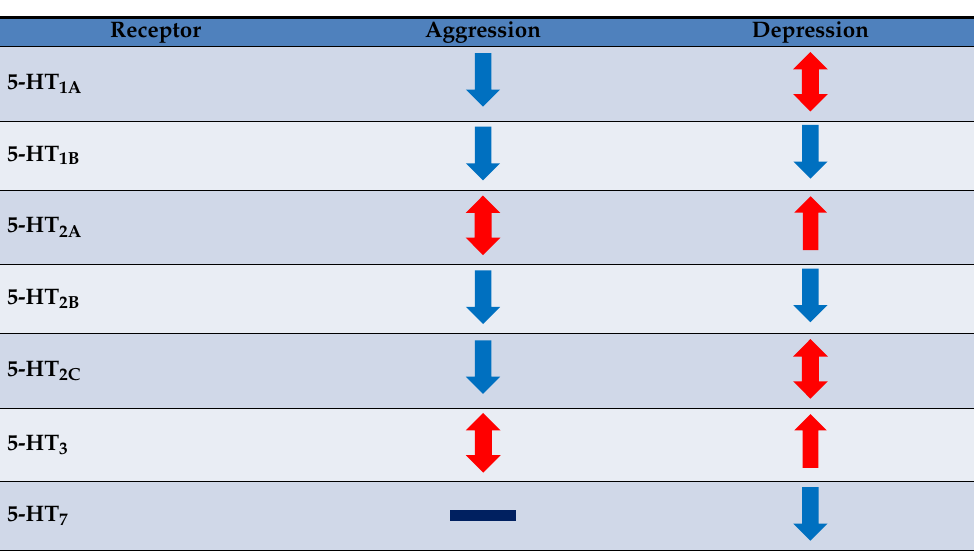
Table 1. Summarized effects of 5-HT receptors on aggression and depression. Activating effect is shown by up arrow; suppressing effect is shown by down arrow; bidirectional effect is shown by double arrow; no effect is shown by straight